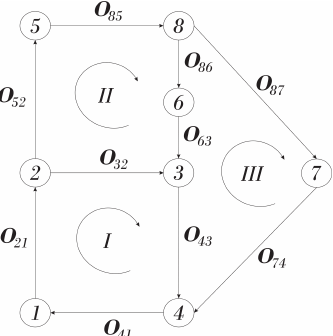
Figure 2. Directed graph of the single flyer planar mechanism.